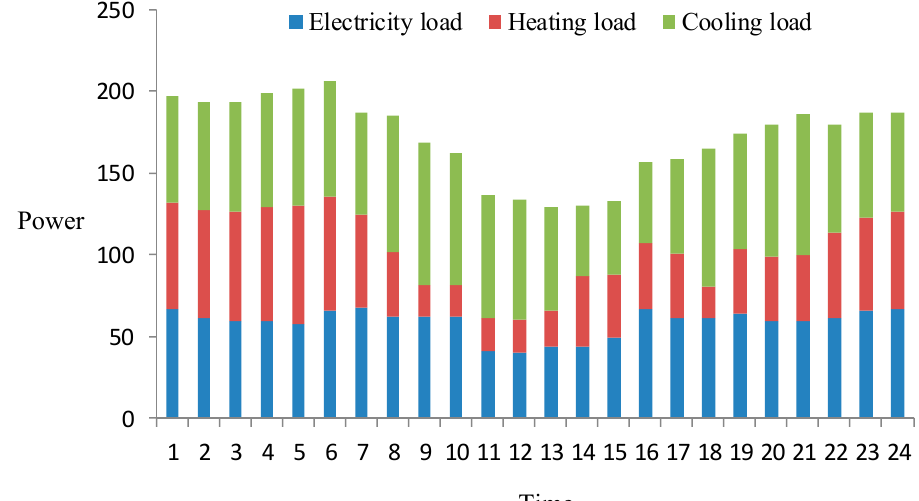
Figure 4. Average hourly electric, cooling, and heating load demands for Tianjin Eco-City (unit: MW).